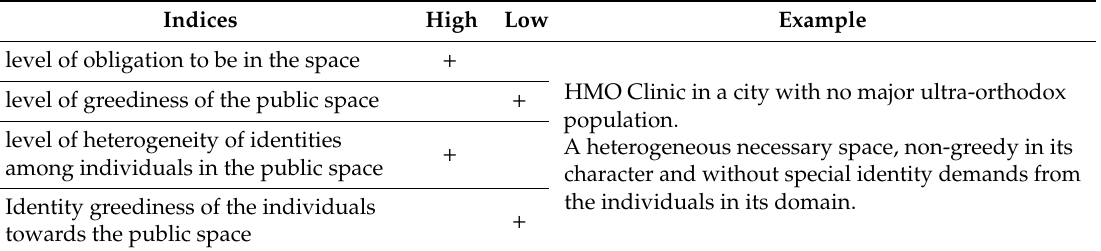
Table A12. Low potential confrontation.